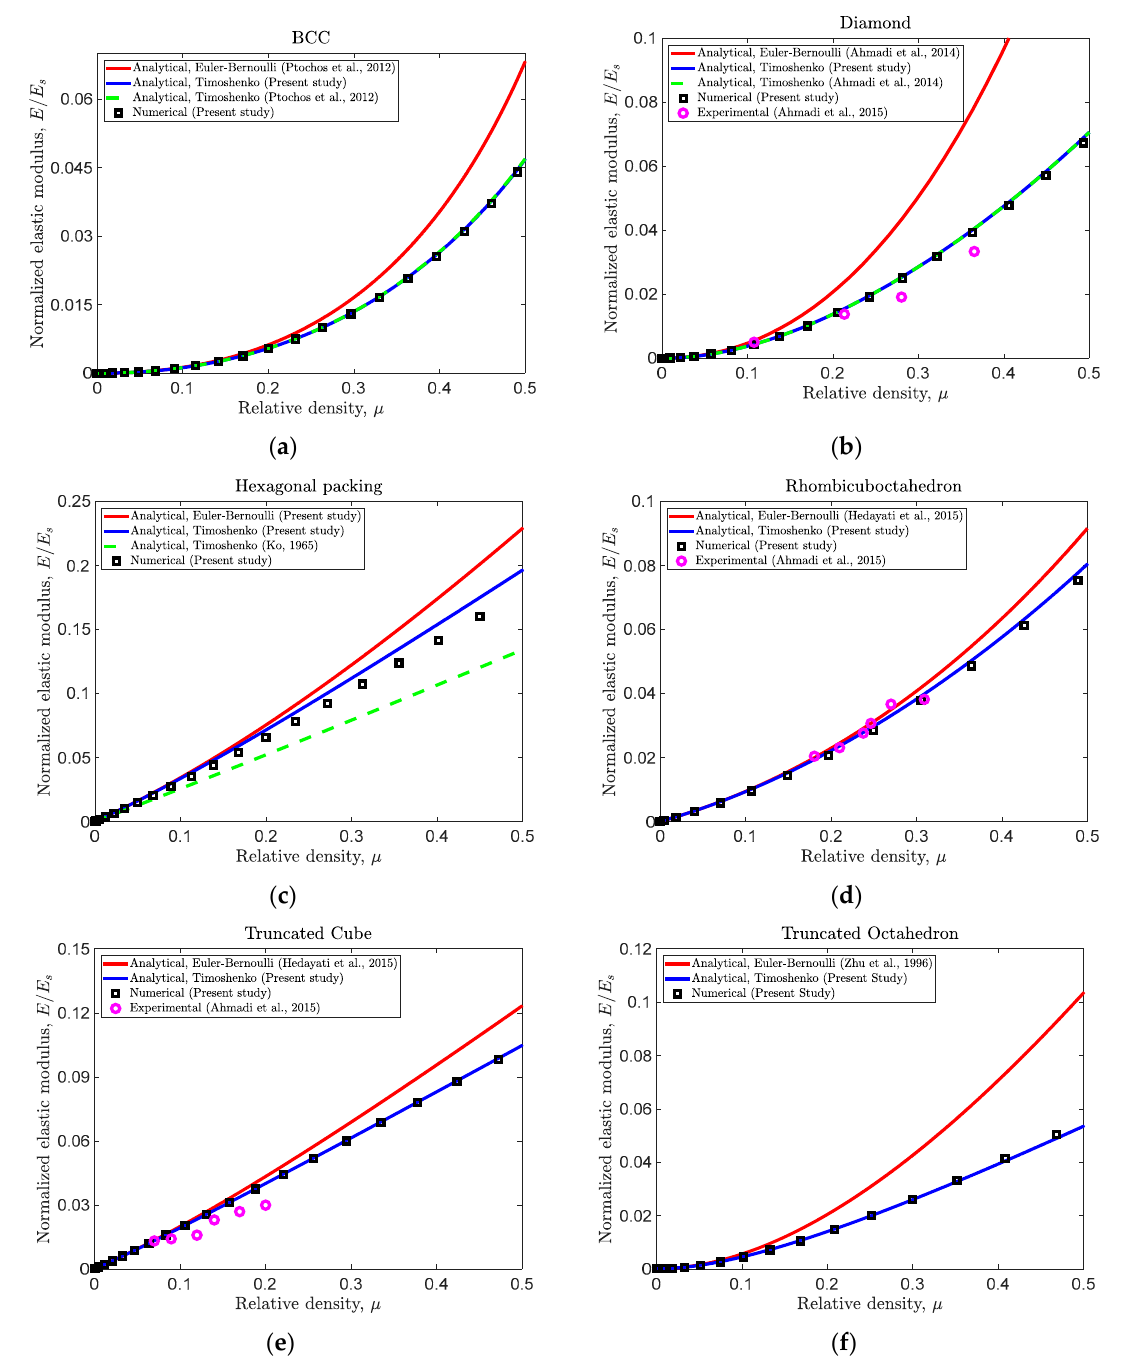
Figure 6. Comparison of analytical (Euler–Bernoulli and Timoshenko) and numerical values of normalized elastic modulus for different unit cell types: ( a ) BCC, ( b ) diamond, ( c ) hexagonal packing, ( d ) rhombicuboctahedron, ( e ) truncated cube, and ( f ) truncated octahedron.